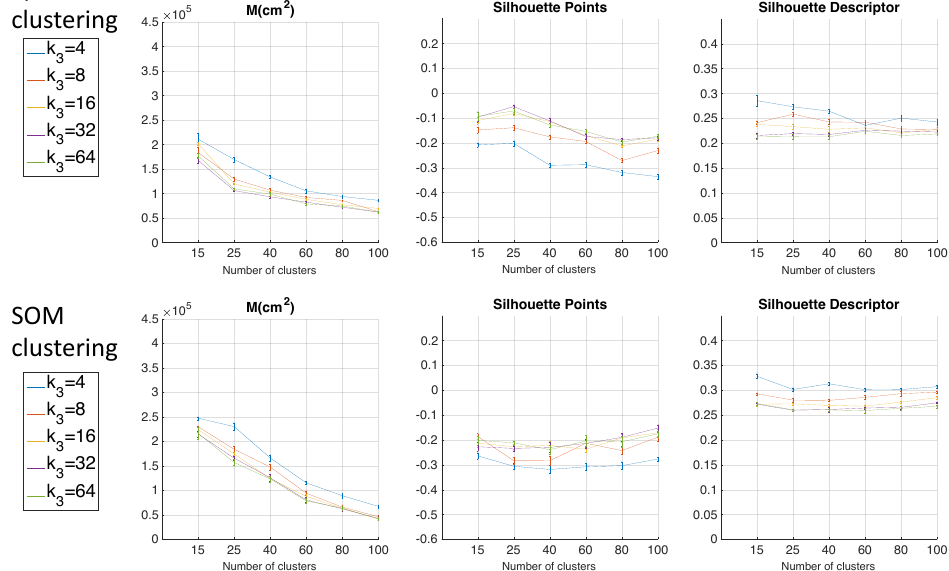
Figure 8. Results of the two clustering methods: average moment of inertia, average silhouette of points, and average silhouette of descriptors vs. number of clusters, when using gist in the Quorum V